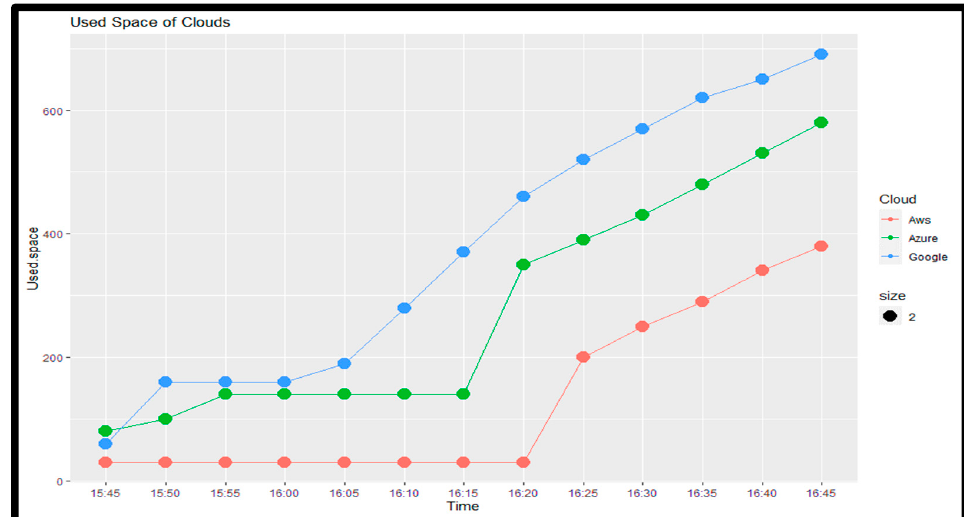
Figure 5. Used space of clouds. Table 2. ANOVA Table for used